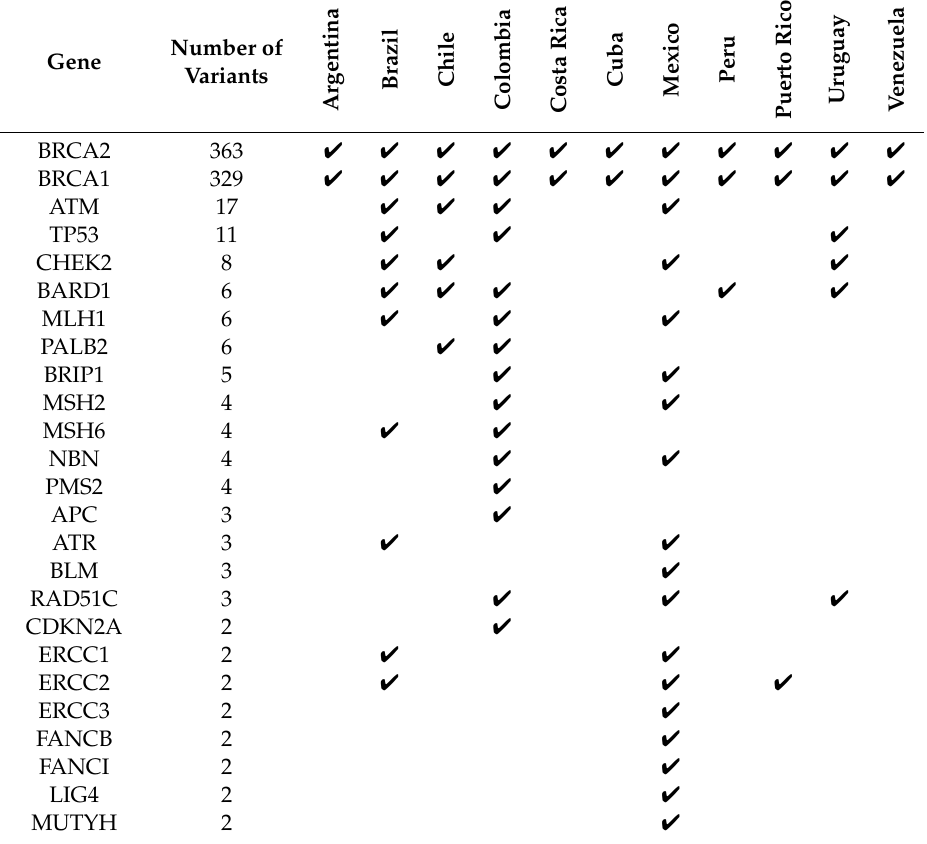
Table 2. Breast Cancer gene variants reported by LA countries in breast